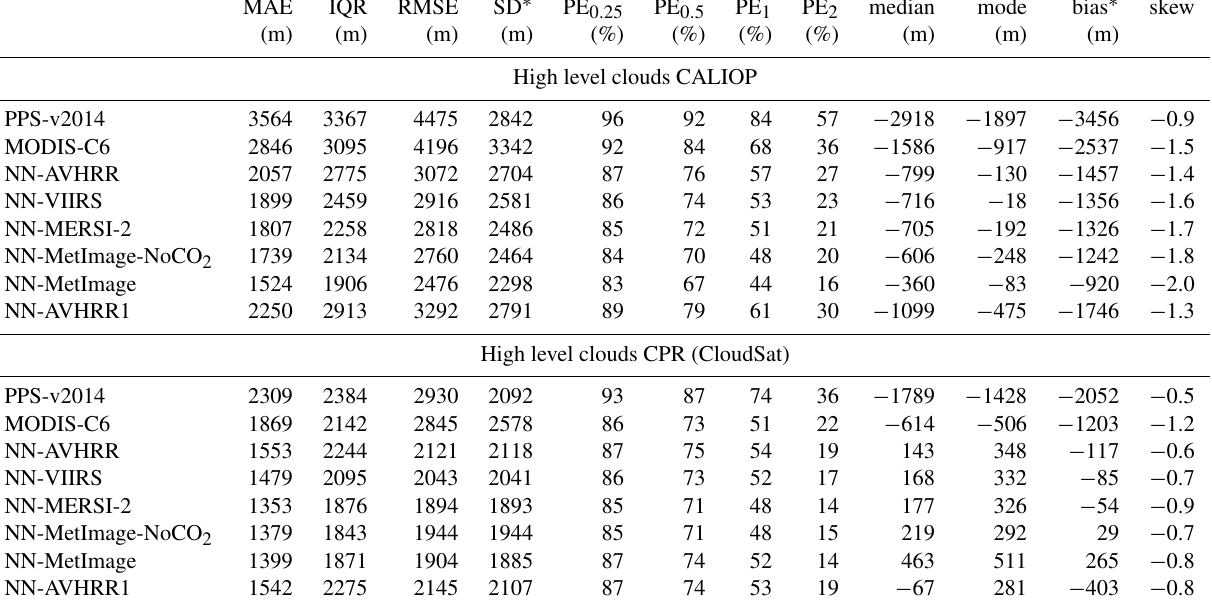
Table 9. Statistic measures for the error distributions for high level clouds. For all measures except skewness it is the case that values closer to zero are better. The statistics are calculated for 625699 matches for CPR (CloudSat) and 798715 matches for CALIOP. The high class comes from CALIOP feature classification flag (class 6 and 7) and for CPR (CloudSat) it is the pixels with heights higher or exactly at the NWP height at 440hPa. PE X describes percentage of absolute errors above X km, see Eq, (1).